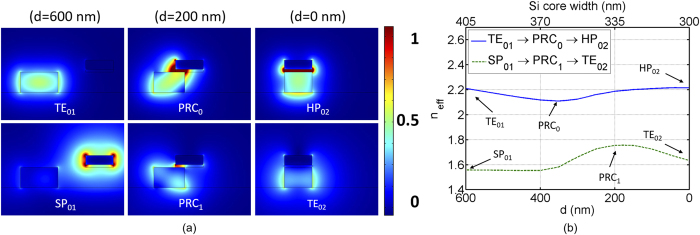
(a) Normalized mode profiles (|E|) at the cross-sections of the PRC structure when the separation distance is changed from d = 600 nm (port 1) to d = 0 nm (port 2). (b) Effective refractive indices as a function of separation distance d, and corresponding Si core width along the device. The main modes (TE01, PRC0, and HP02) and the secondary modes (SP01, PRC1, and TE02) are plotted in blue and dashed green, respectively.